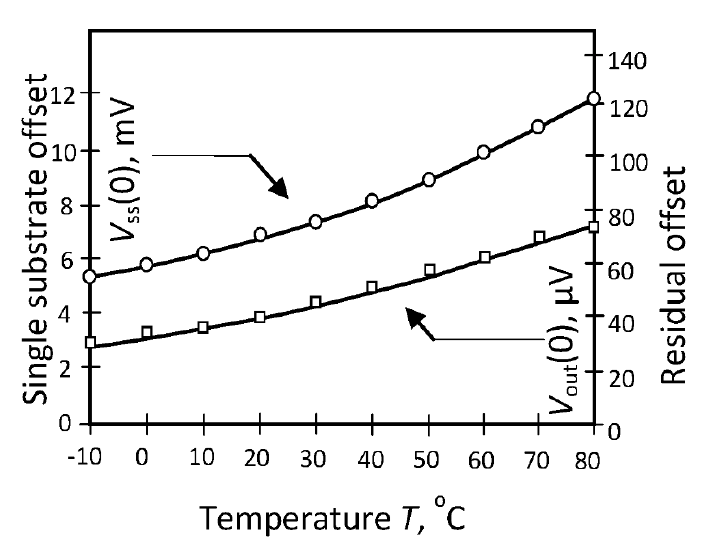
Figure 4. Temperature dependences of single offset V ss (0) and residual offset V out (0) at a supply I s = 3 mA.